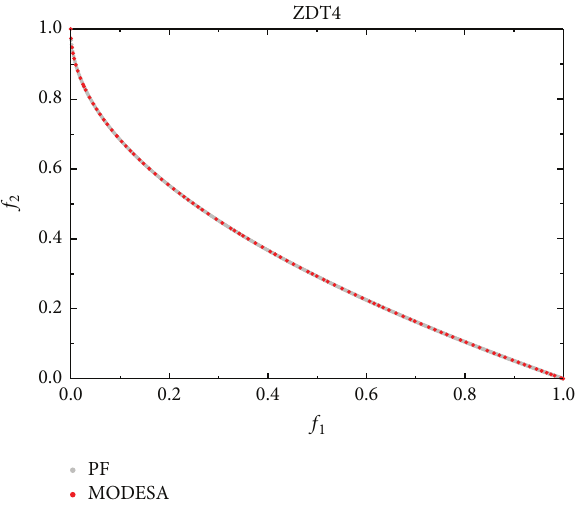
Figure 4: Plots of the nondominated solutions with the lowest IGD- metric values found by MODESA in 10 runs in the objective space on ZDT4 where 𝑁 = 100 and 𝑇 = 250